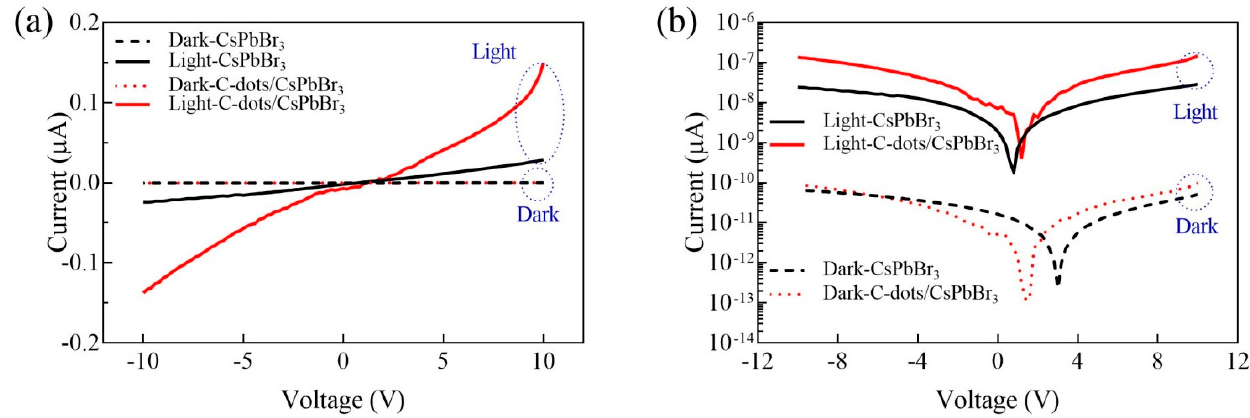
Figure 5. Linear ( a ) and logarithm ( b ) I-V curves for the pure perovskite and C-dot/CsPbBr 3 perovskite devices.